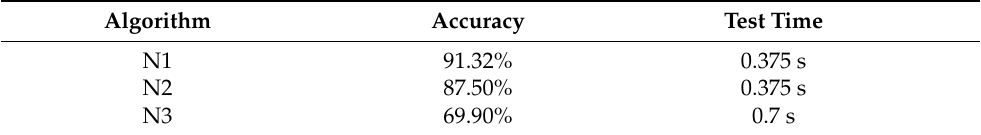
Table 3. Classification accuracy using different networks of the proposed algorithms.